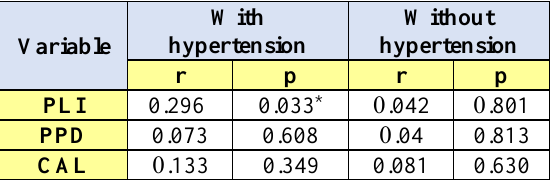
Table 6: Correlation coefficients between Matrix metalloproteinase-8 with plaque index, probing pocket depth and clinical attachment level, among patients with and without